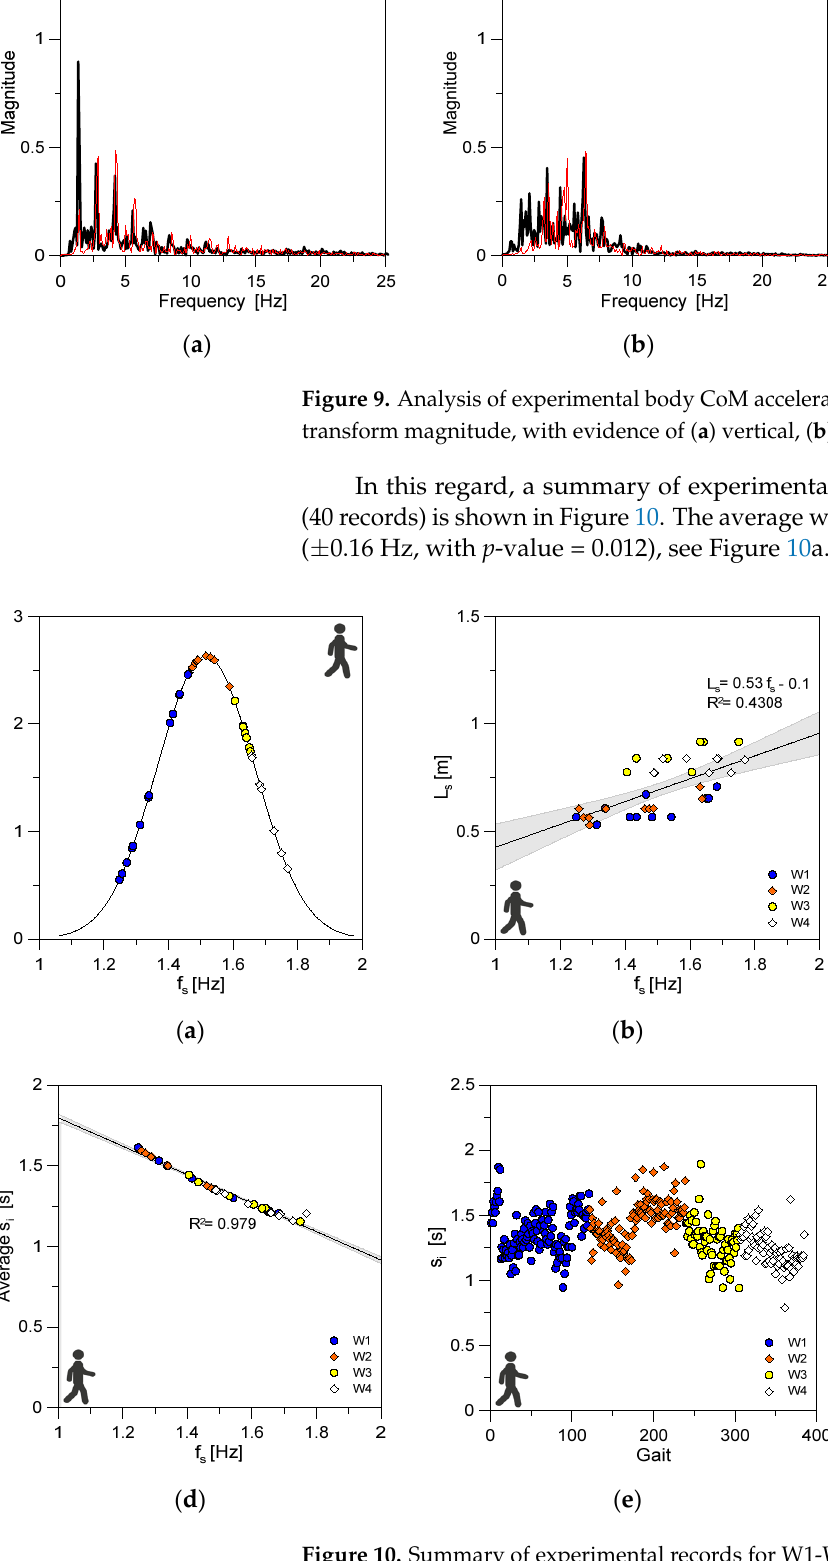
Figure 10. Summary of experimental records for W1-W4 configurations: ( a ) Gaussian distribution of samples (40 in total), ( b ) stride length, ( c ) walking speed, ( d ) average stride interval, ( e ) stride interval variation. The 95% confidence interval is shown in grey colour.